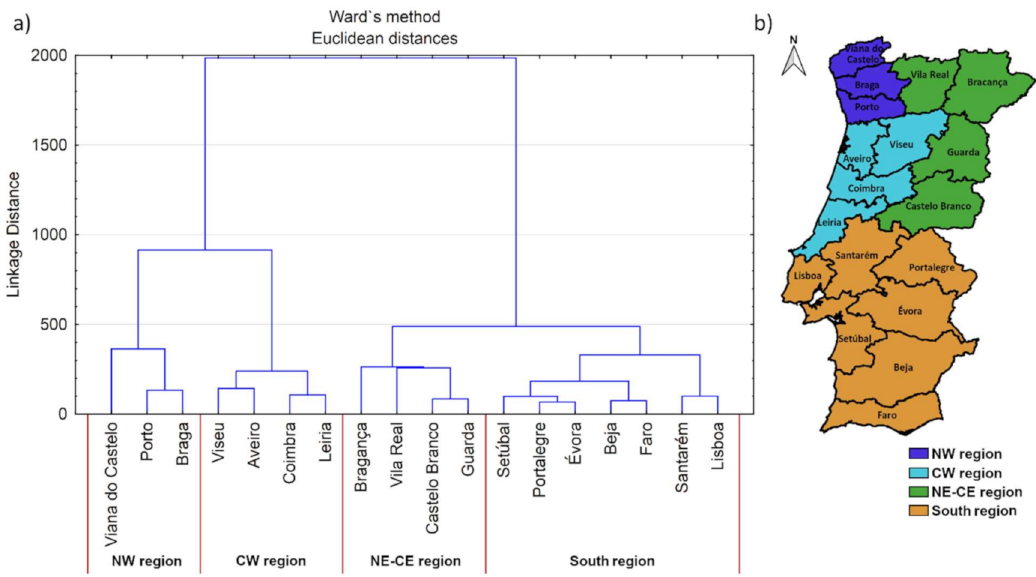
Figure 1. ( a ) Graphical illustration of Ward’s method—the tree diagram with the assigned clusters and ( b ) schematic representation of the assigned